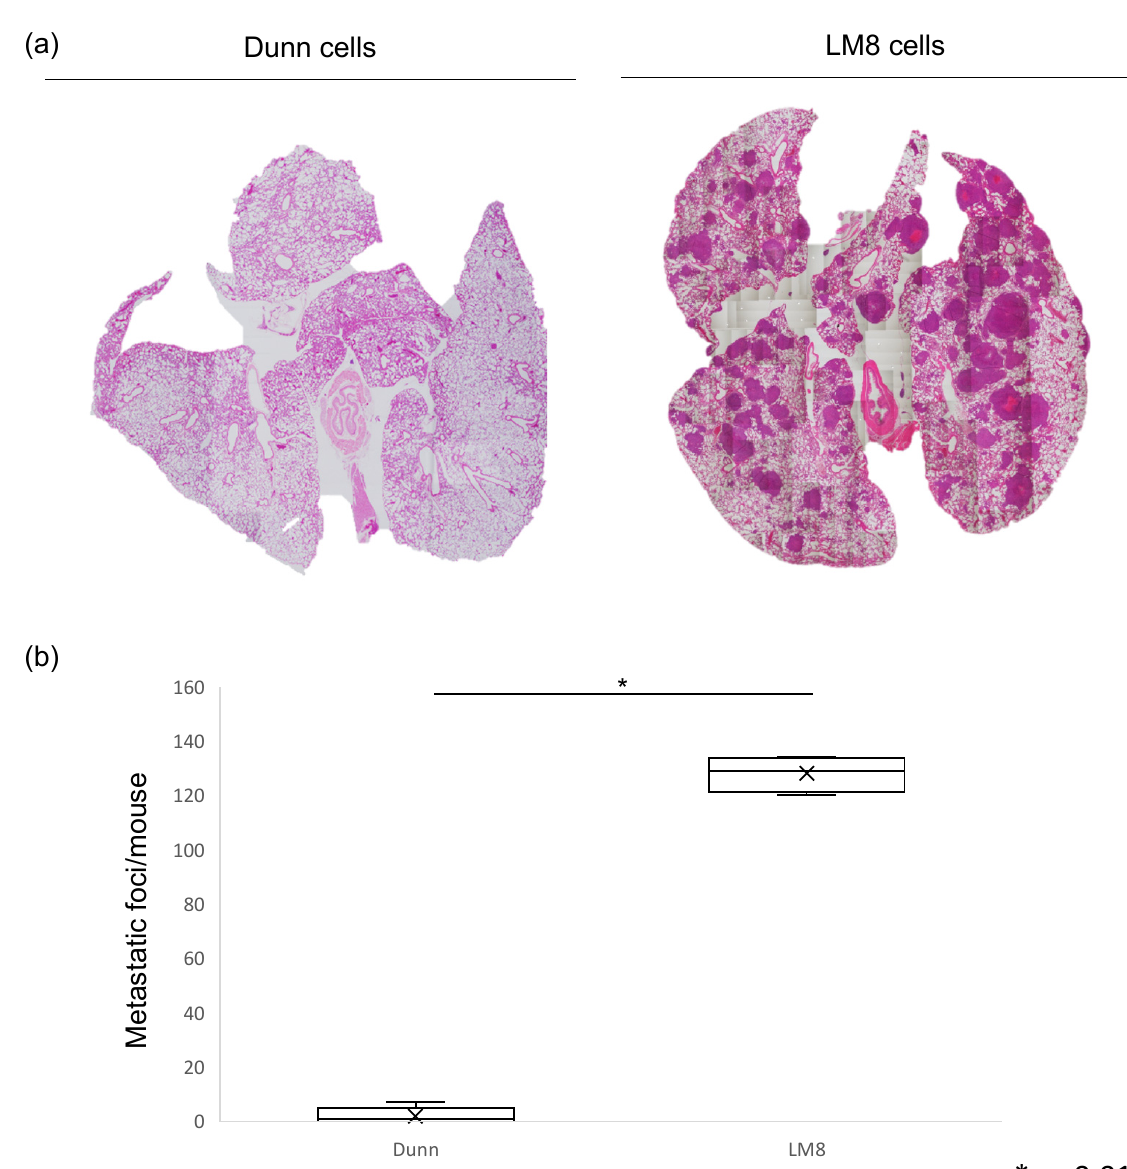
Figure 1. Evaluation of lung metastases between Dunn and LM8. ( a ) Hematoxylin and eosin staining was performed ( Left : Dunn, Right : LM8). The metastatic foci was counted. ( b ) The number of metastatic foci of LM8 in the lung was significantly higher than Dunn (* p < 0.01).